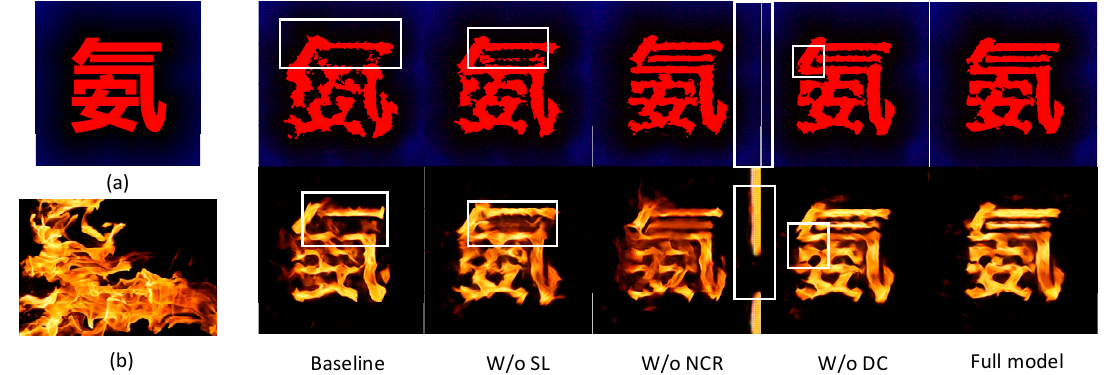
Figure 6. Comparison chart of ablation experiments: ( a ) represents our original data, and ( b ) is the style features we need to migrate. The first row on the right is the resulting graph of the texture generation network G S , and the second row is the final output graph. From left to right are the output results of the model we proposed above.